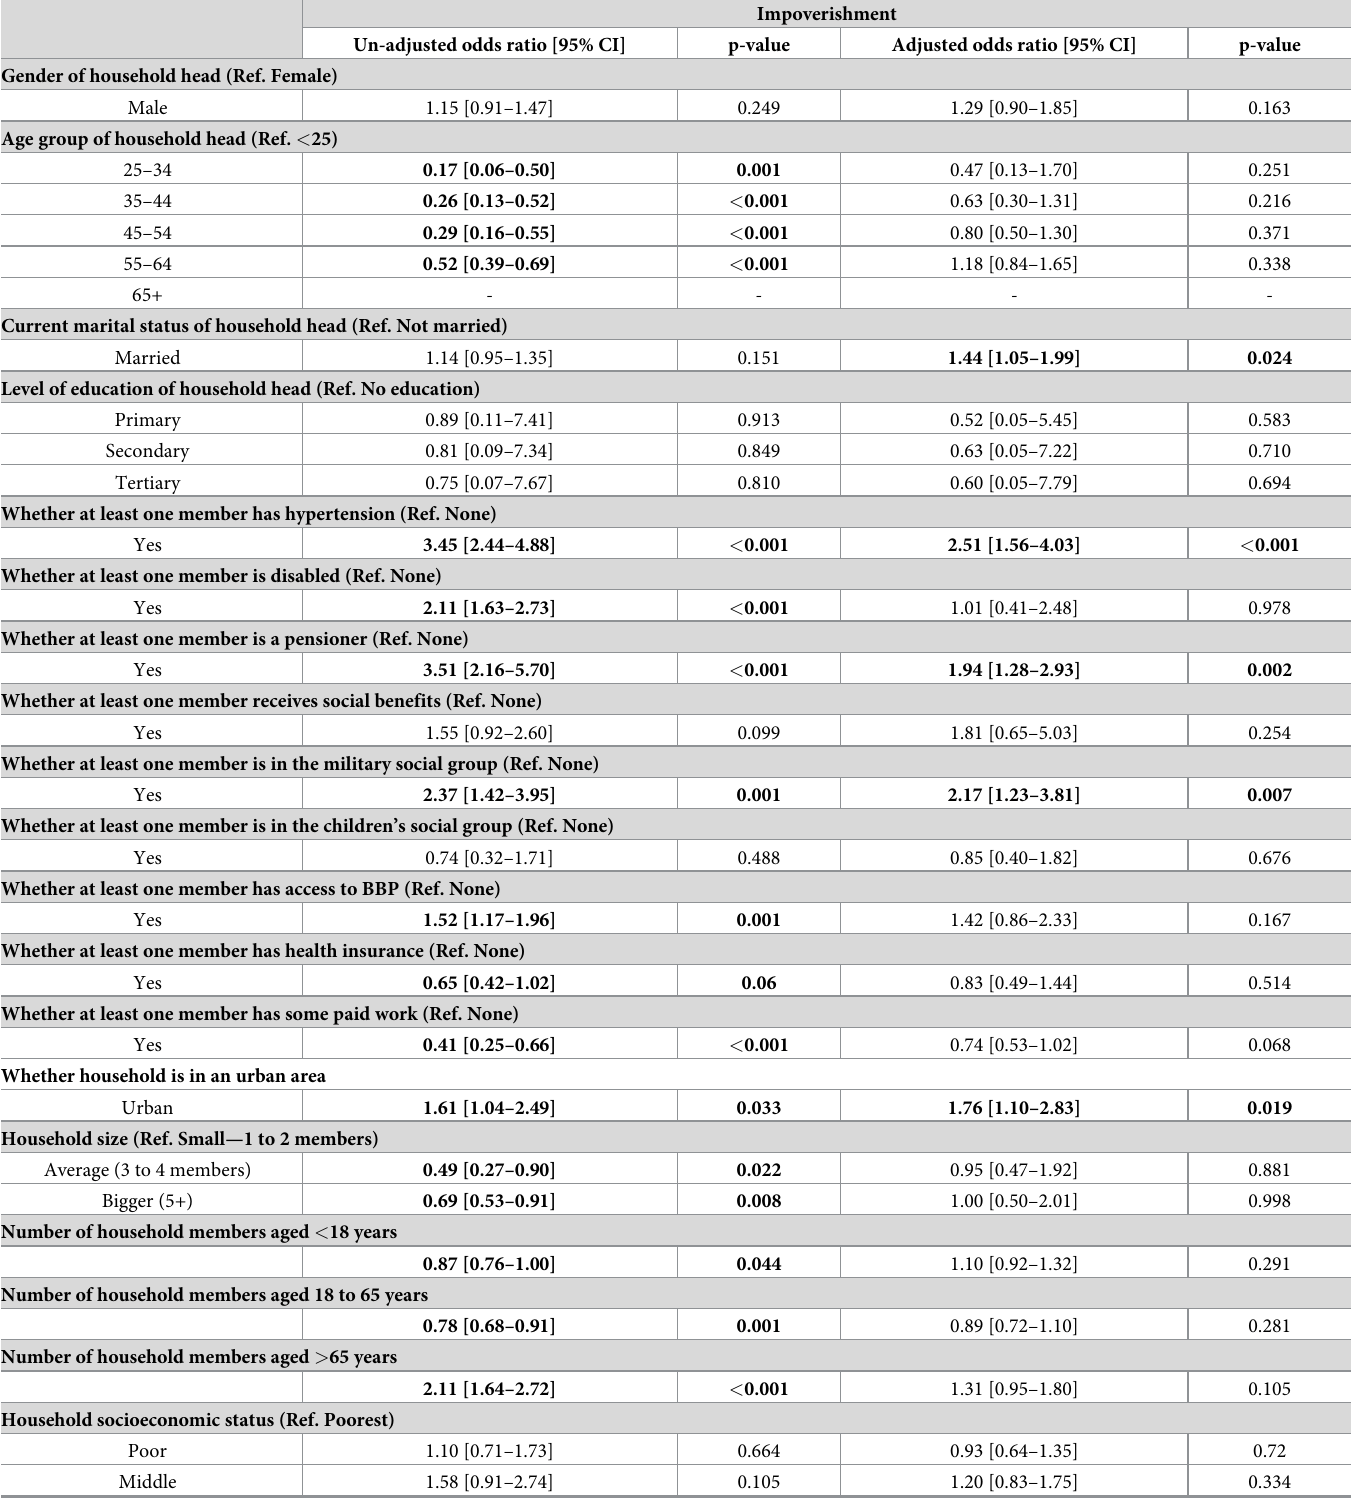
Table 8. Un-adjusted and adjusted odds ratio for the correlates impoverishing health expenditure in Armenia—2018